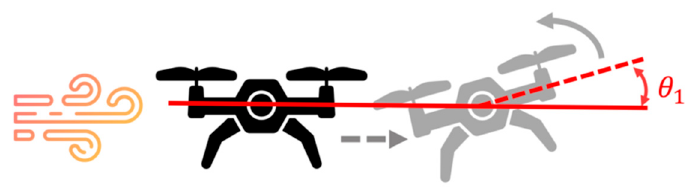
Figure 5. Roll angle correction θ 1 .